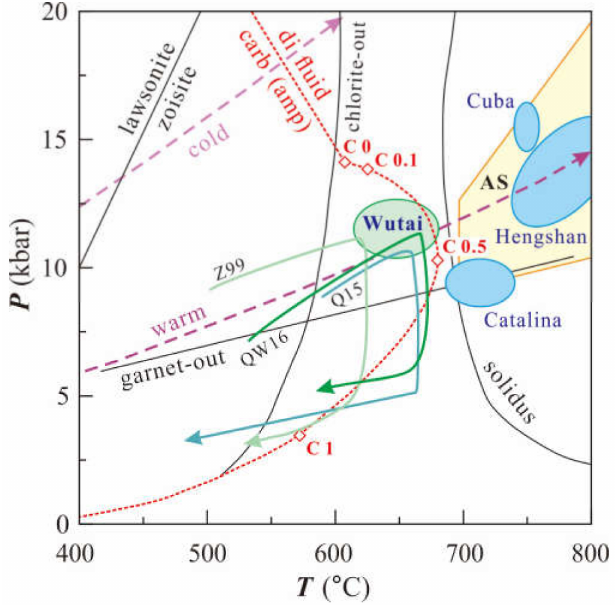
Figure 8. Phase diagram showing the P – T paths (solid curves with arrows) and peak P – T condition for the metabasites in the Wutai Complex (Z99, [33]; Q15, [35]; QW16, [29]). This figure also shows: (1) experimentally determined phase relationships for H 2 O-saturated MORB, including the rock’s solidus and the stability ranges of garnet, chlorite, zoisite, and lawsonite (solid curves) [104]; (2) cal- culated devolatilization reaction (dashed curve with diamonds), carbonates (carb) ± amphibolite (amp) = diopside (di) + fluid [106], labeled with X (CO 2 ) in the resultant fluid along the univariate line (C 0.5, X (CO 2 ) = 0.5); (3) the peak metamorphic P – T conditions (ellipses) of the typical warm subduc- tion complexes Cuba and Catalina [112–114], and that of the Hengshan Complex [26–29]; and (4) the ancient (2.7–0.8 Ga) subduction P – T range (polygonal field labeled with AS) [115,116] and the oceanic slab-top P – T paths representative of Archean examples (dashed curves with arrows)